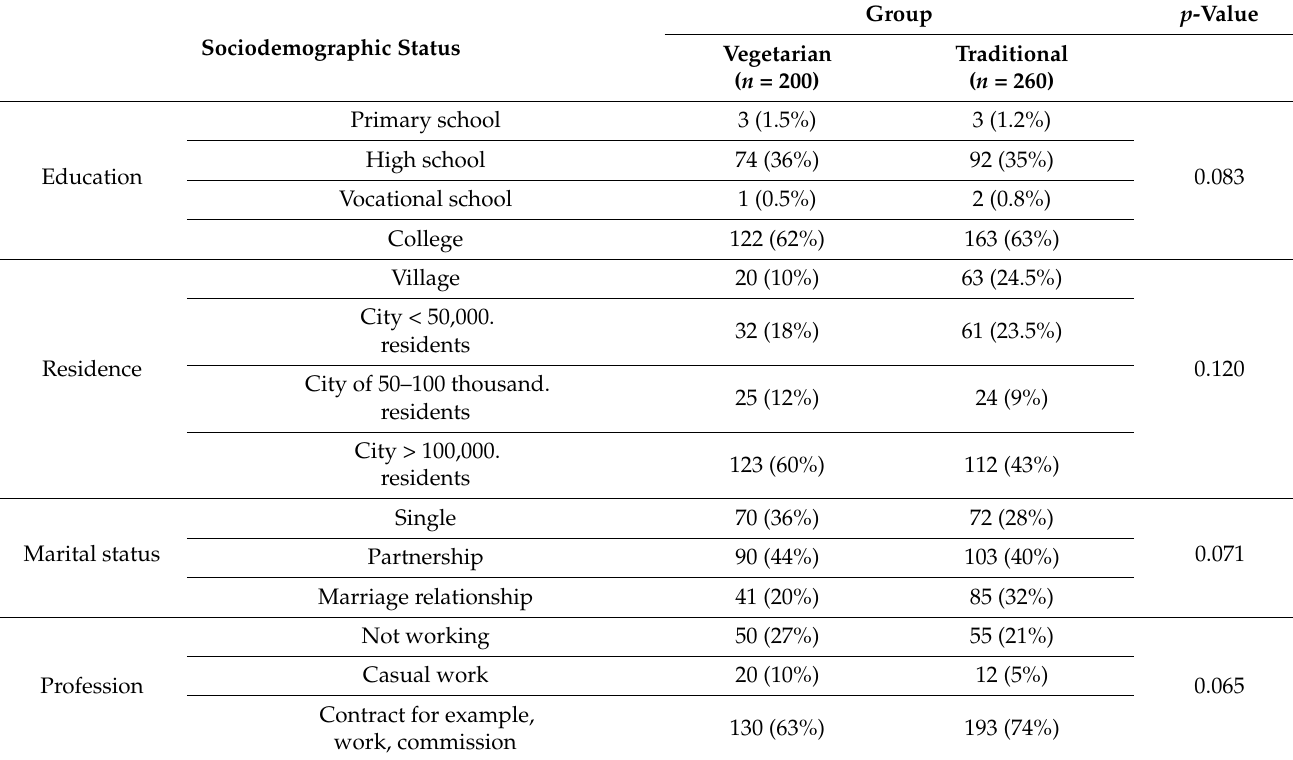
Table 1. Sociodemographic status of groups ( n = 460).